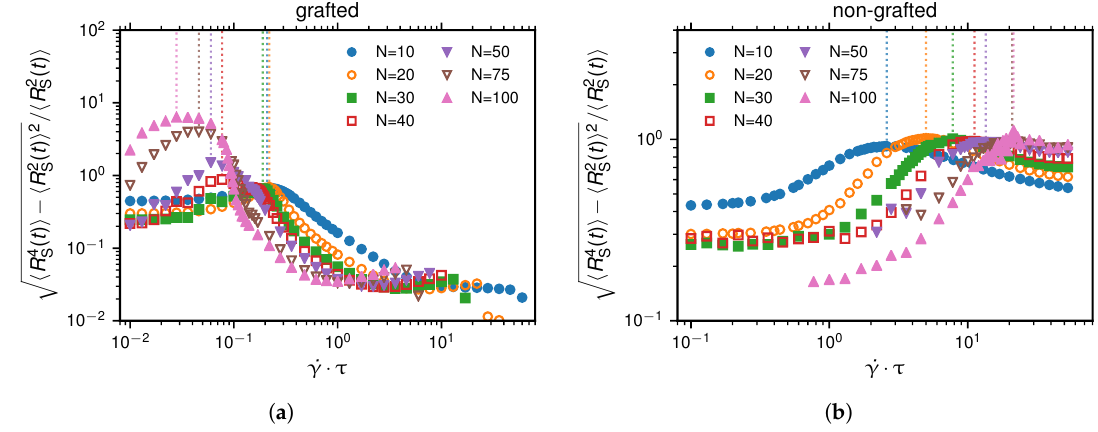
Figure 4. The maximum of the normalized standard deviation of the mean-squared elongation of the (cid:104) R 4 ( t ) (cid:105) − (cid:104) R 2 ( t ) (cid:105) 2 / (cid:104) R 2 ( t ) (cid:105) , has previously been used to define the critical chain in flow direction, S S S shear rate indicated by dashed lines [14]. Subfigures ( a , b ) depict the grafted and the non-grafted (cid:113) scenario,